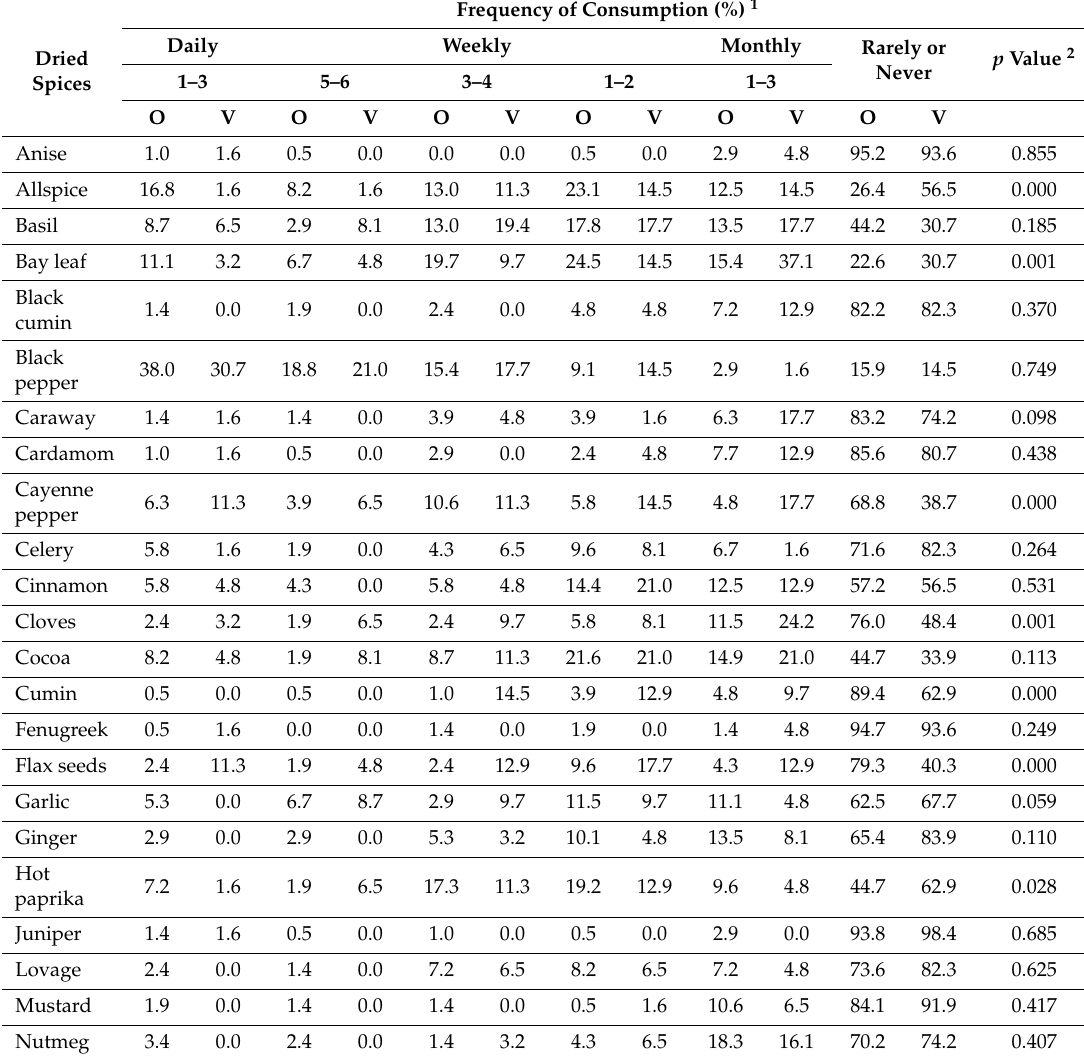
Table 4. Frequency of consumption of dried spices among adult omnivores and